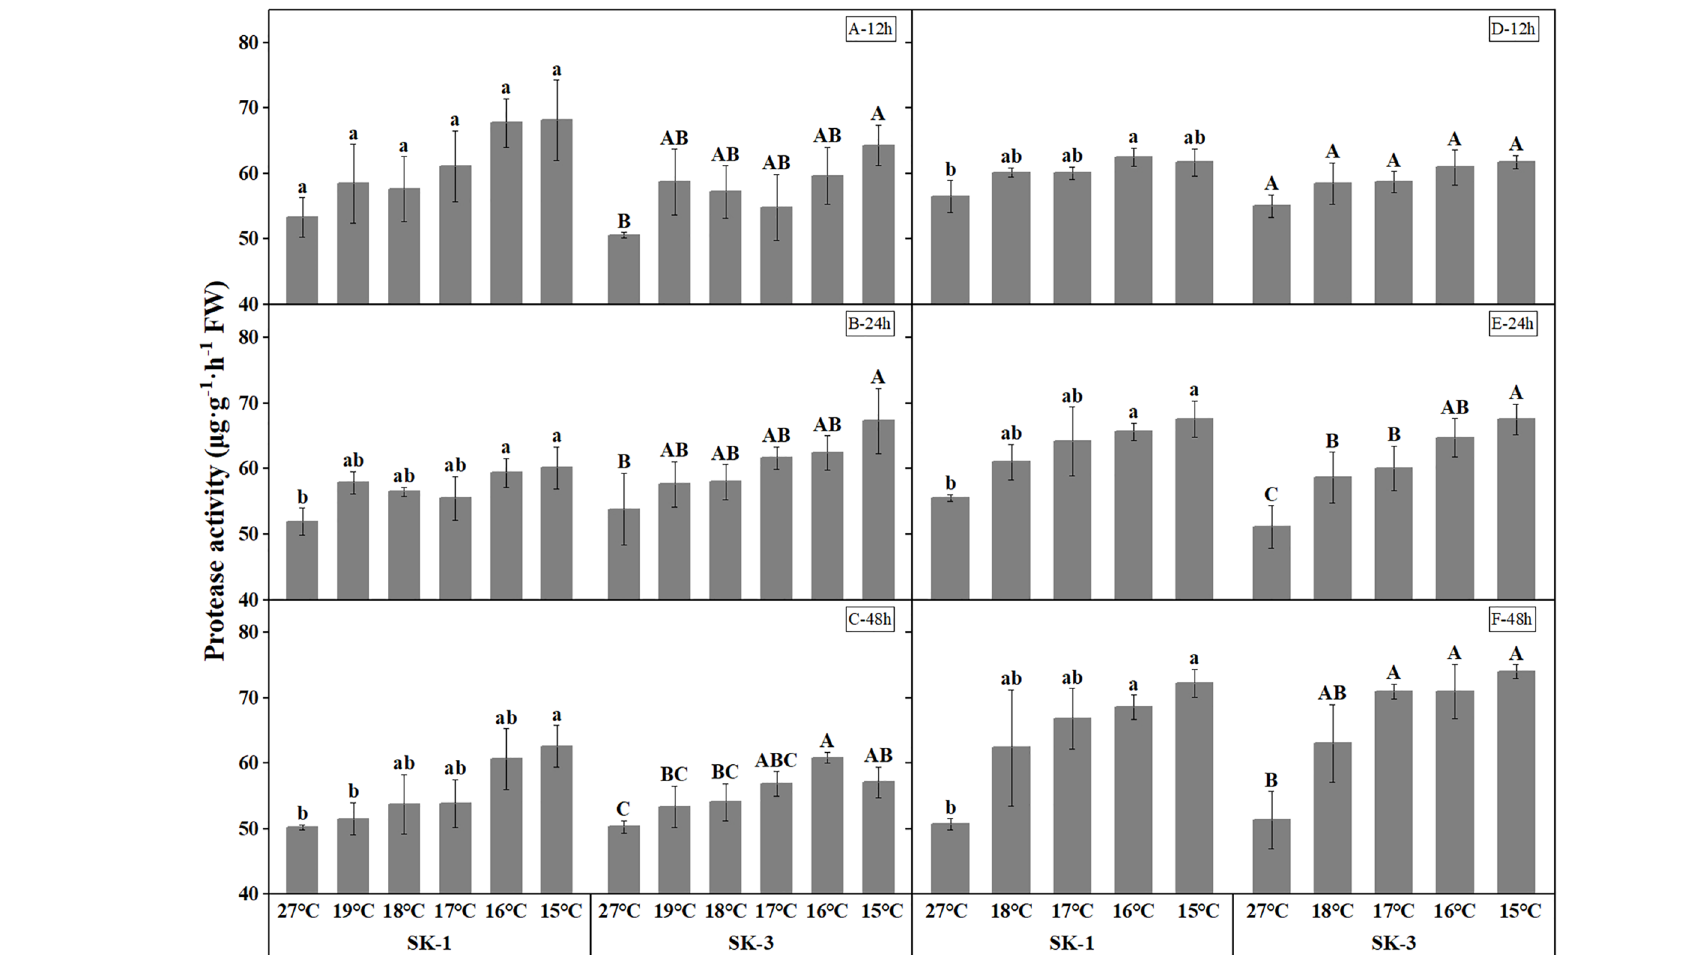
FIGURE 11 Effect of low temperature stress on protease activity in cotton squares in 2020 ( A-C : 12h, 24h, 48h stress) and 2021 ( D-F : 12h, 24h, 48h stress). FW represents fresh weight. Different lowercase letters indicate the signi fi cant differences between the treatments of the variety SK1, and different capital letters indicate the signi fi cant differences between the treatments of the variety SK3